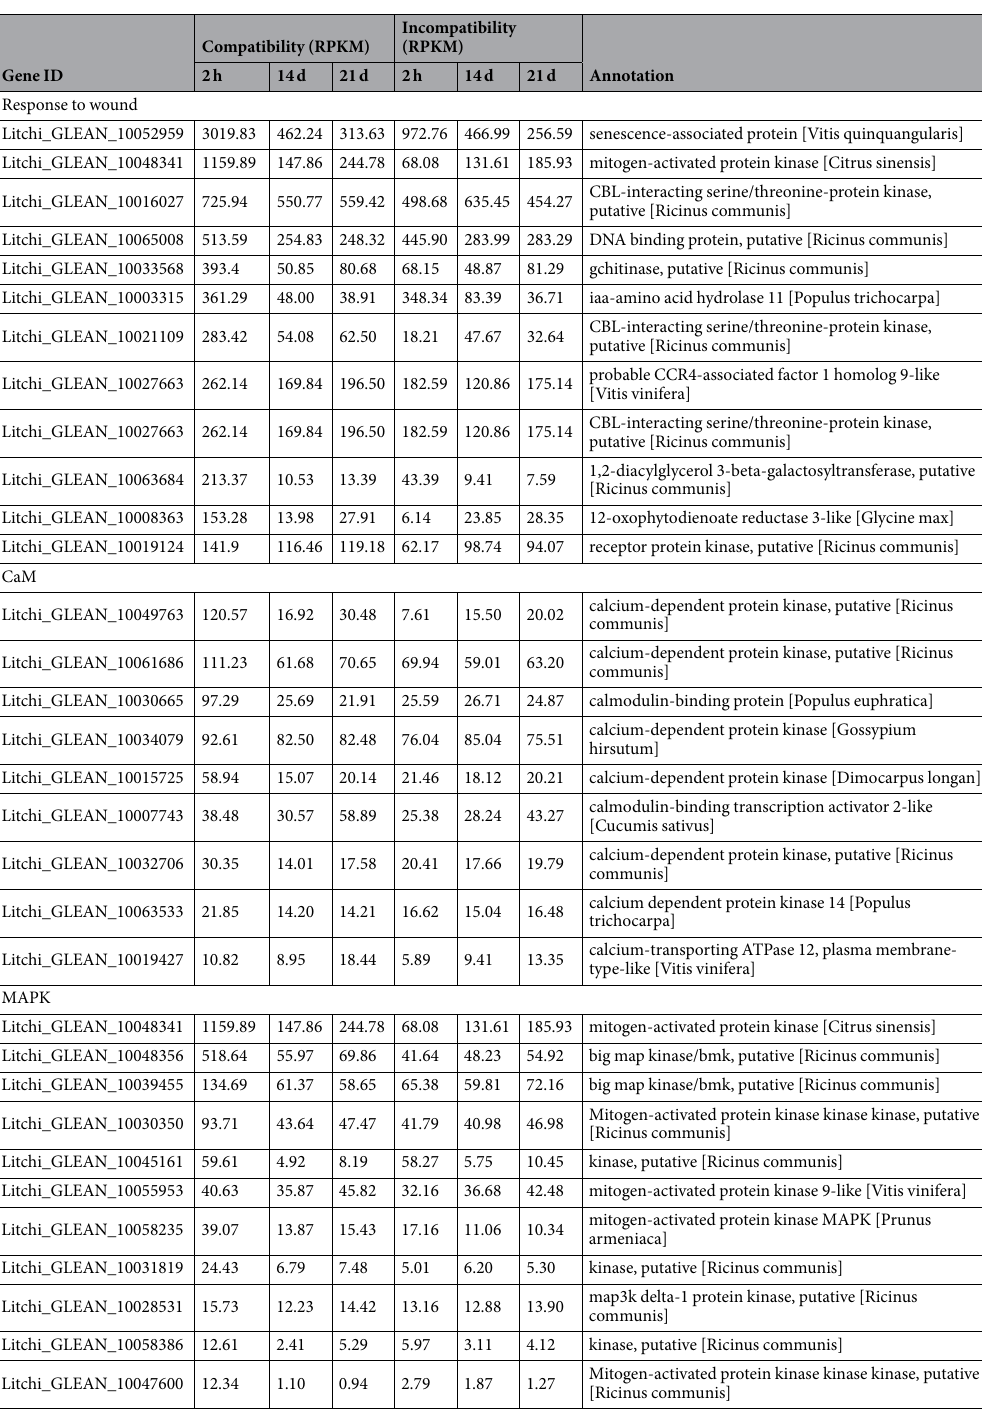
Table 2. List of DEGs related to signal transduction during graft healing